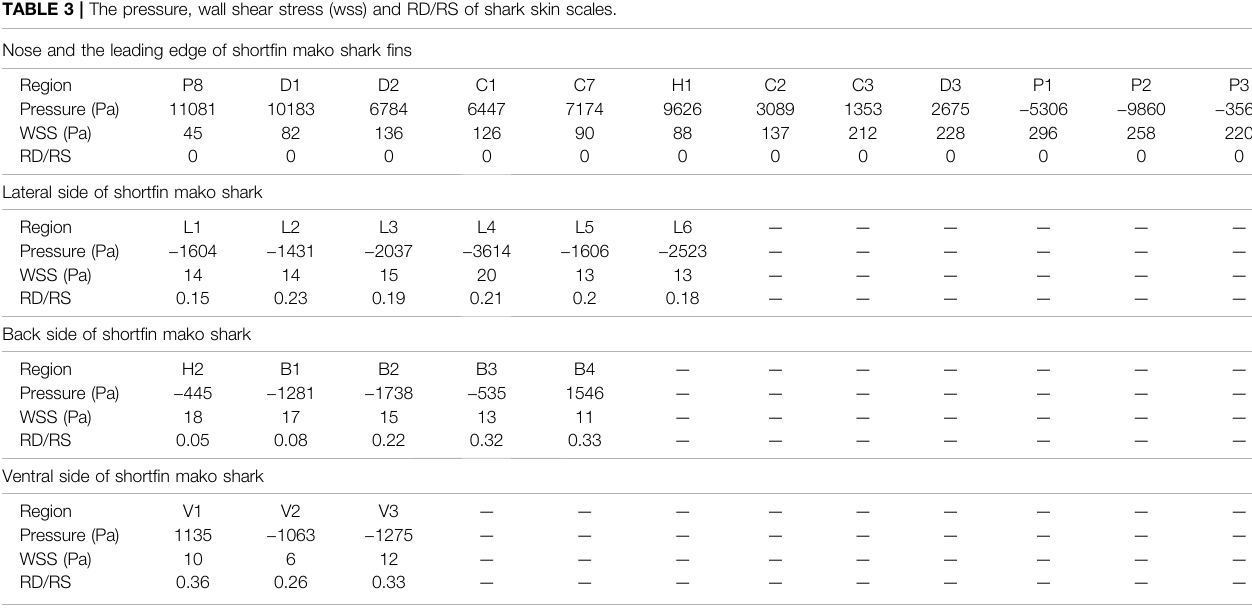
TABLE 3 | The pressure, wall shear stress (wss) and RD/RS of shark skin scales. Nose and the leading edge of short fi n mako shark fi ns Region